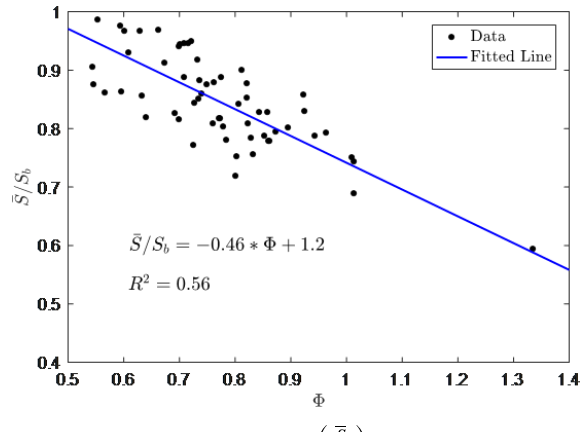
(cid:16) S (cid:17) under long-term average S b